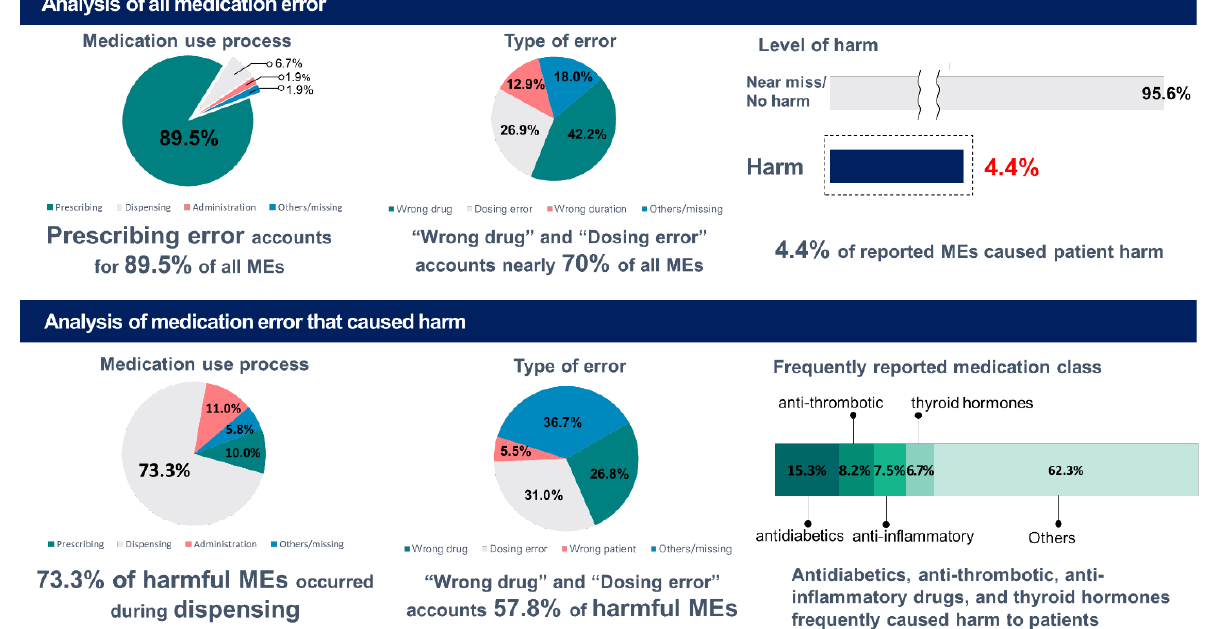
Figure 2. Diagrammatic summary of study findings.